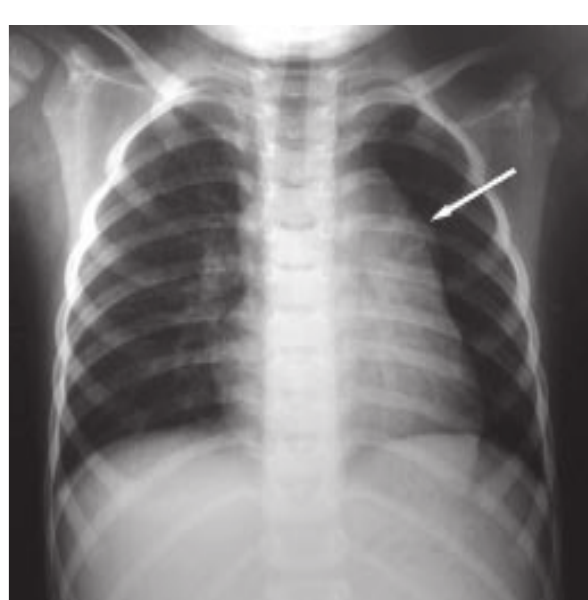
Fig. 1 – Radiograma de tórax em incidência póstero-anterior, com abaulamento do arco médio